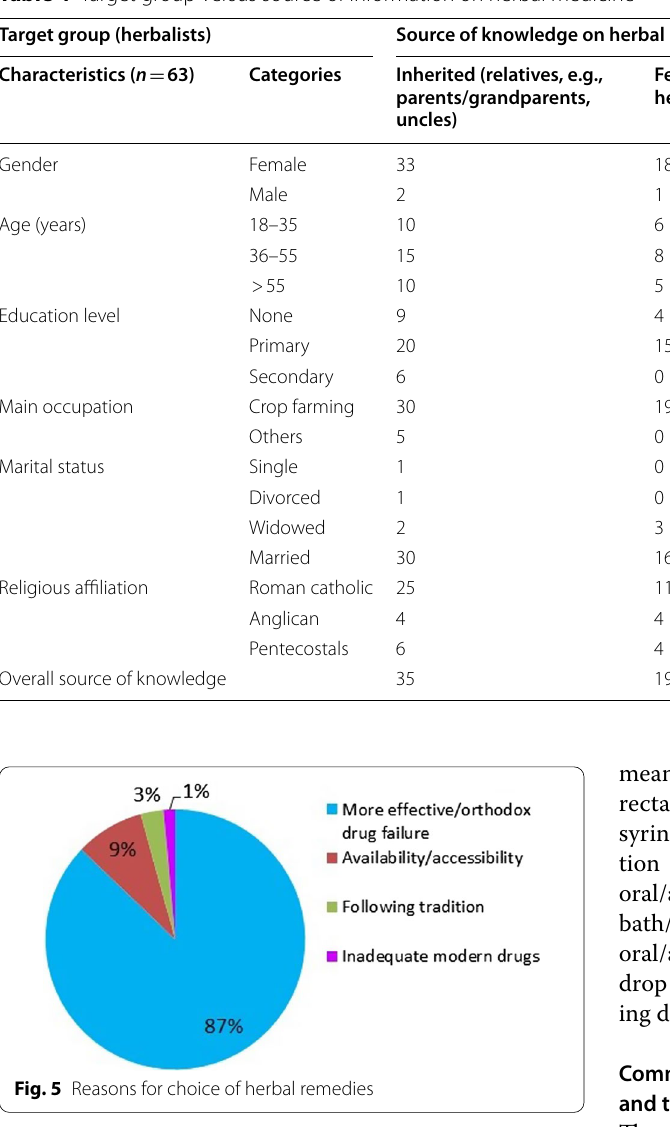
Table 5 Informant consensus factor (FIC) for usage of potential anti-candida plants Most common